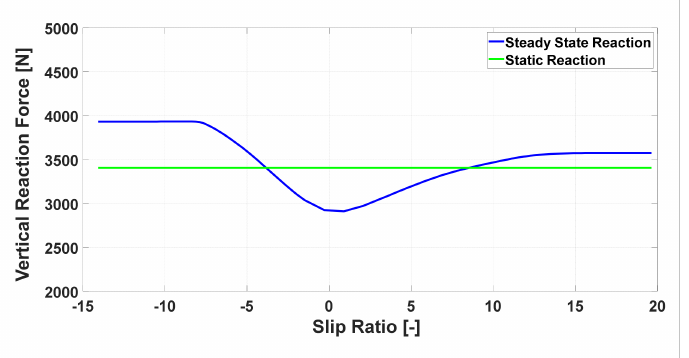
Figure 16. Vertical reaction vs. slip